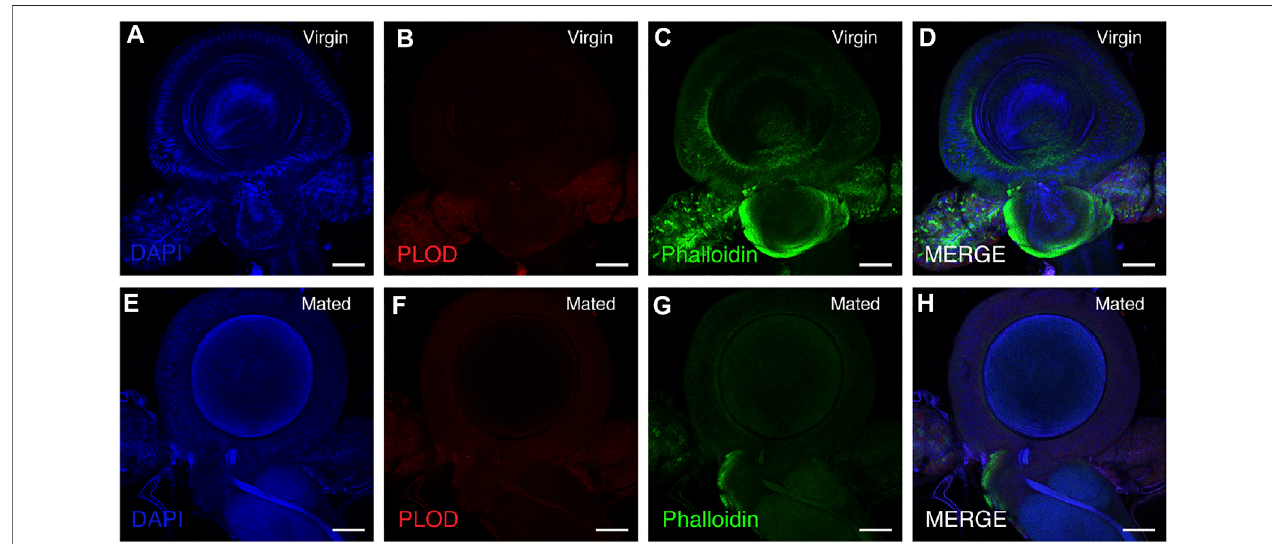
FIGURE 5 | PLOD1 in spermathecae of virgin and mated queens of bumblebee, at 24 h post mating. PLOD1 was expressed at lower levels in the mated queen spermathecae (F) than in the virgin queen spermathecae (B) . In the panels, blue indicates DAPI staining, and green indicates Phalloidin staining. Scale bars, 75 µm.